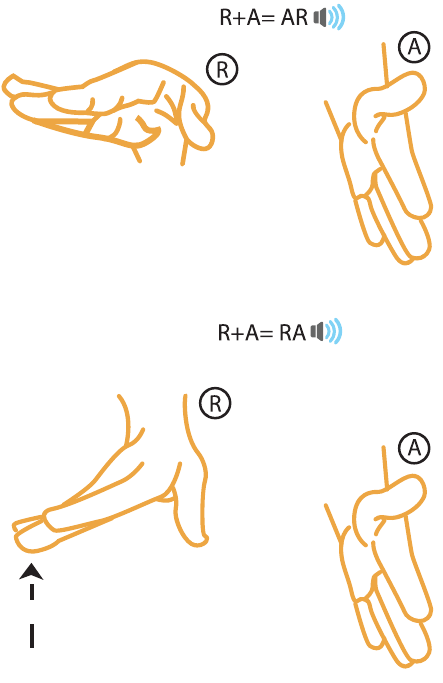
Figure 5. Hands’ posture for AR and RA